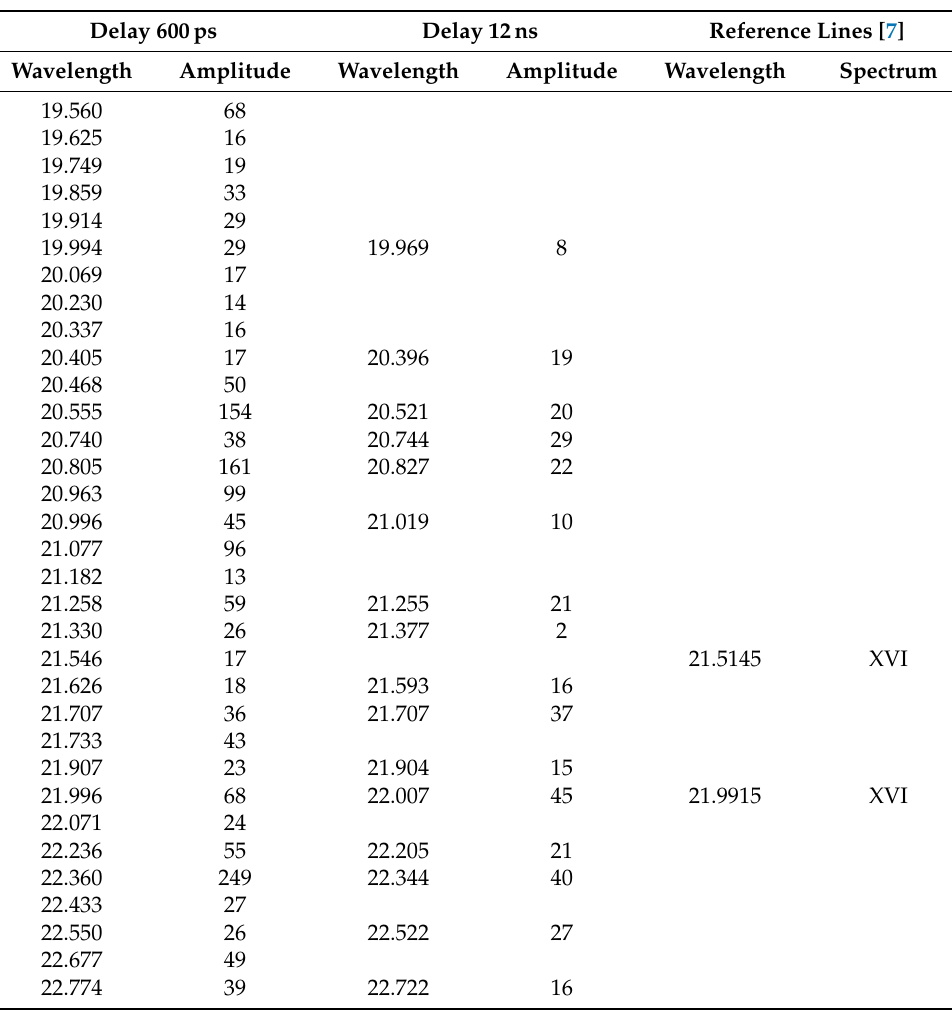
Table 2. Cobalt data recorded at positions 5mm (600ps delay) and 100mm (12ns delay)